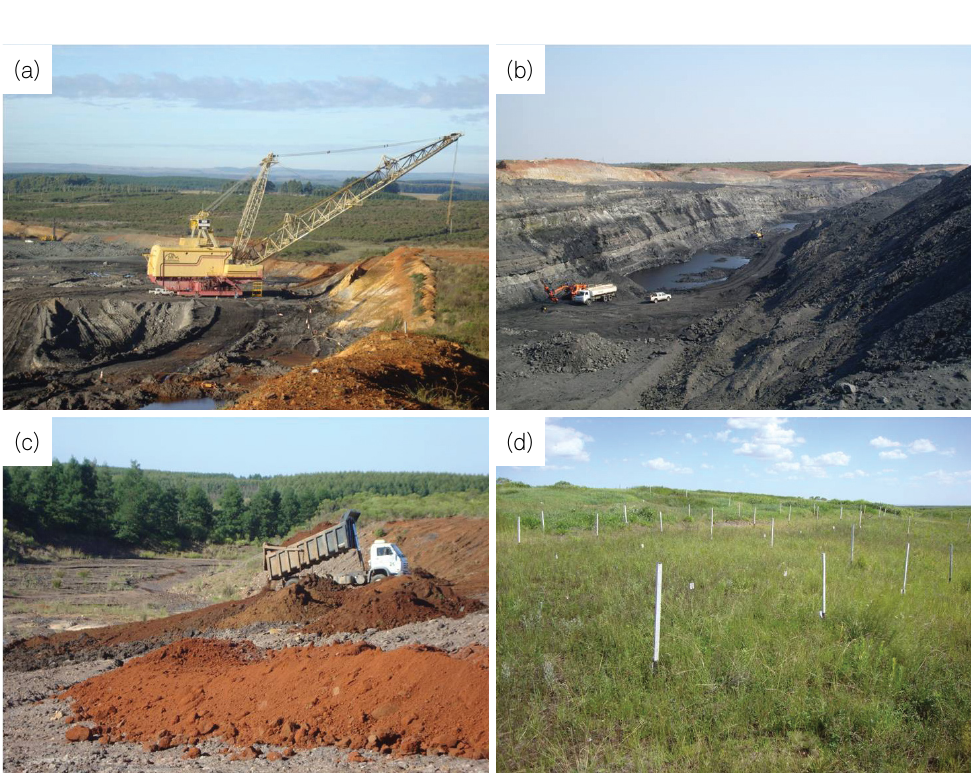
Figure 1. Simplified sequence of the steps from coal mining to the start of the experiment, as follows: (a) removal of surface soil horizons; (b) exposure and extraction of coal layers of interest; (c) distribution of a mixture of Lixisol horizons (previously removed) on the topographically reclaimed area, forming constructed soil; and (d) performance of the experiment on the constructed